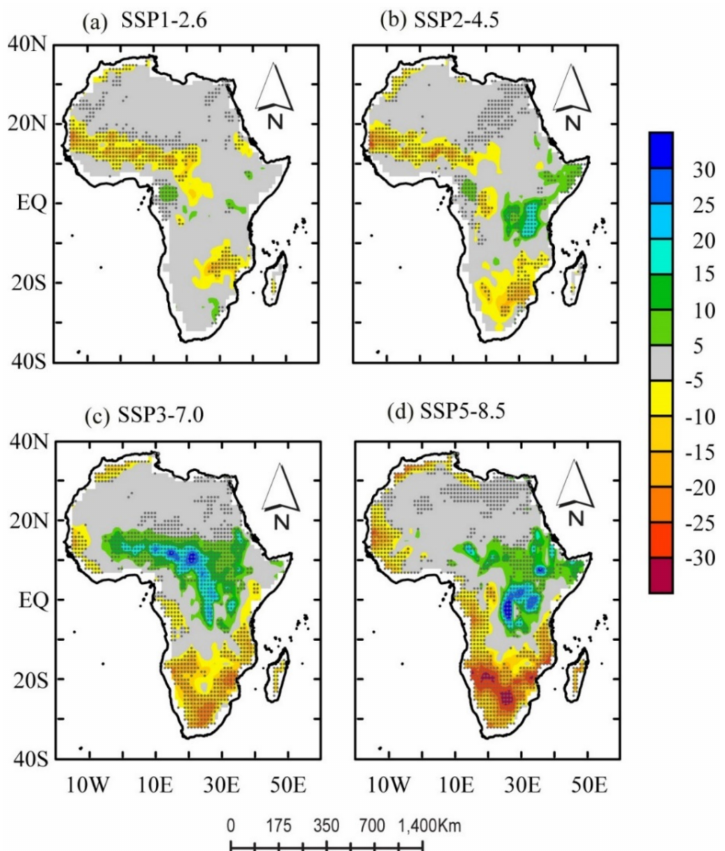
Figure 6. The linear trends of evapotranspiration under the SSP1-2.6, 2-4.5, 3-7.0, and 5-8.5 scenarios in the future period (2020–2099). The positive values depict an increase, and the negative values depict a decrease. The unit is mm decade − 1 . The black dots indicate that the trend passes the 0.05 significance